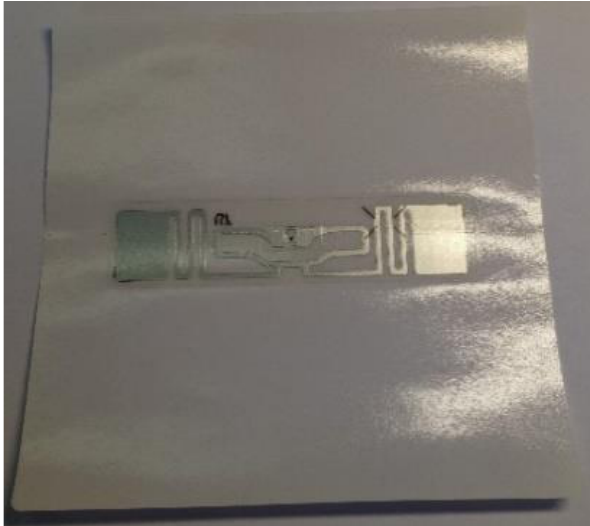
Figure 2. RFID identifier sample.